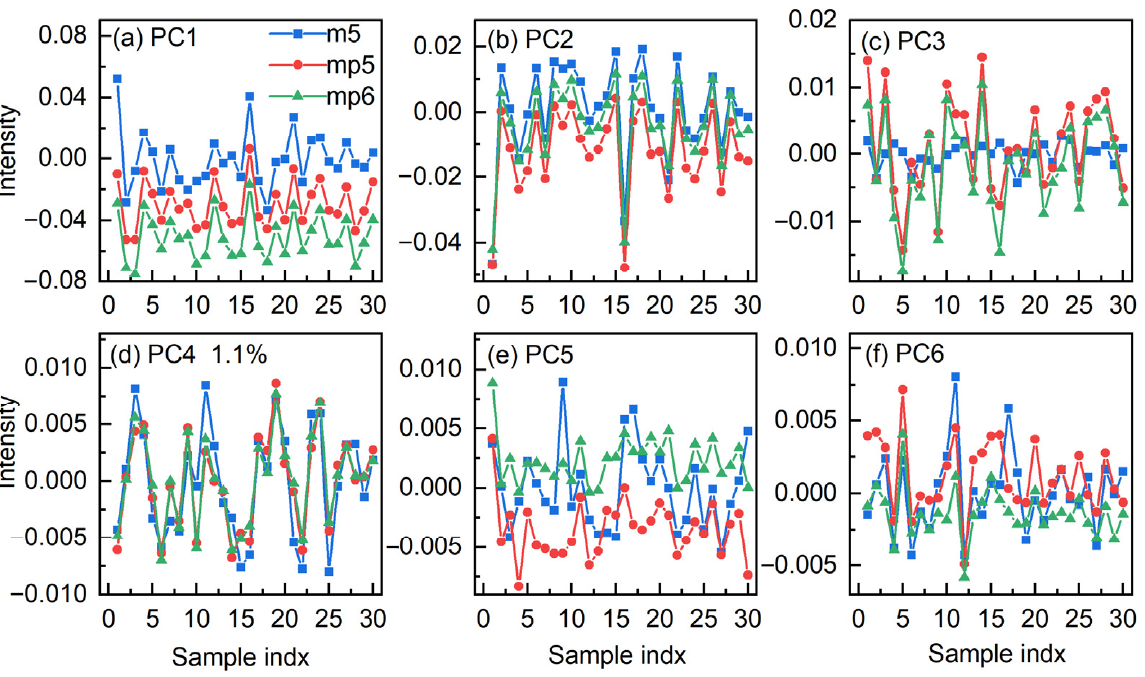
Figure 4. Comparison of the scores in the first through the sixth ( a – f ) PCs in the individual part for the spectra from the instruments m5, mp5, and mp6. The blue square, red circle, and green triangle represent the score for instrument m5, mp5, and mp6, respectively.